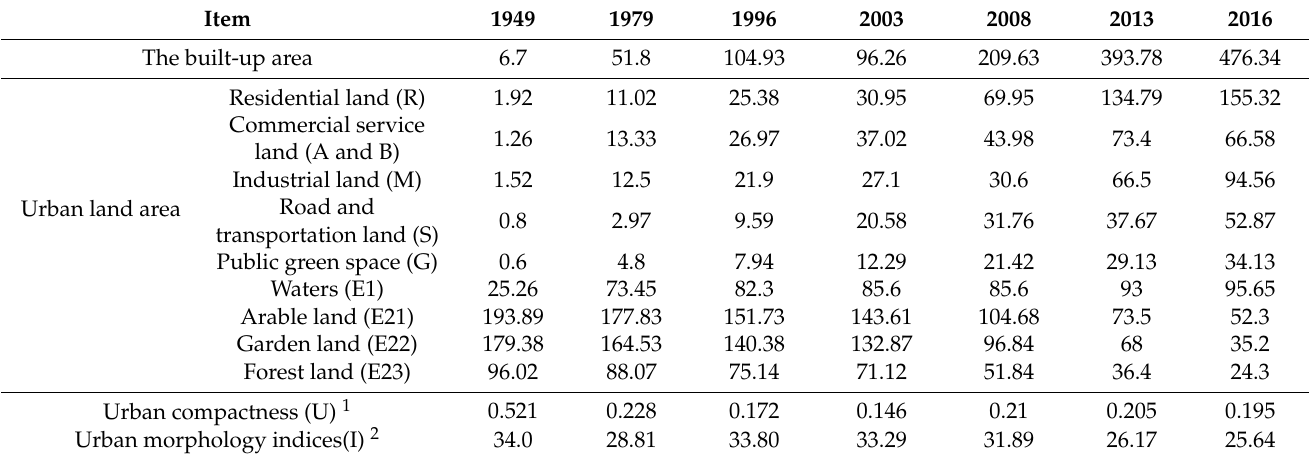
Table 1. Urban land use indices, urban compactness, and urban morphology indices.